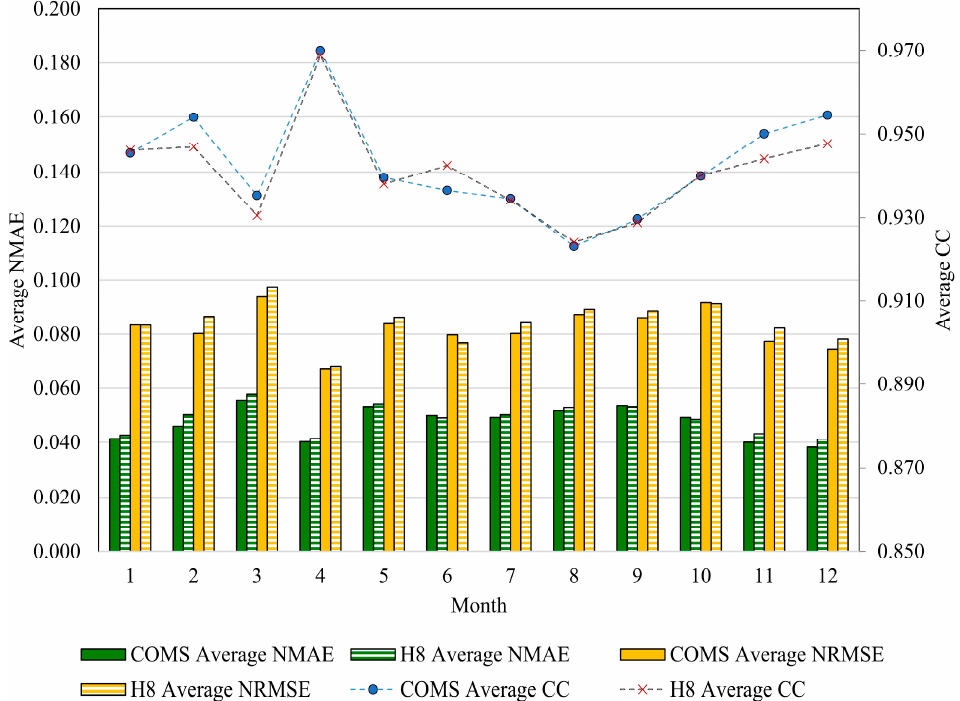
Figure 12. Seasonal variation for the 2 h-ahead PV forecast presented by monthly averaged error metrics.